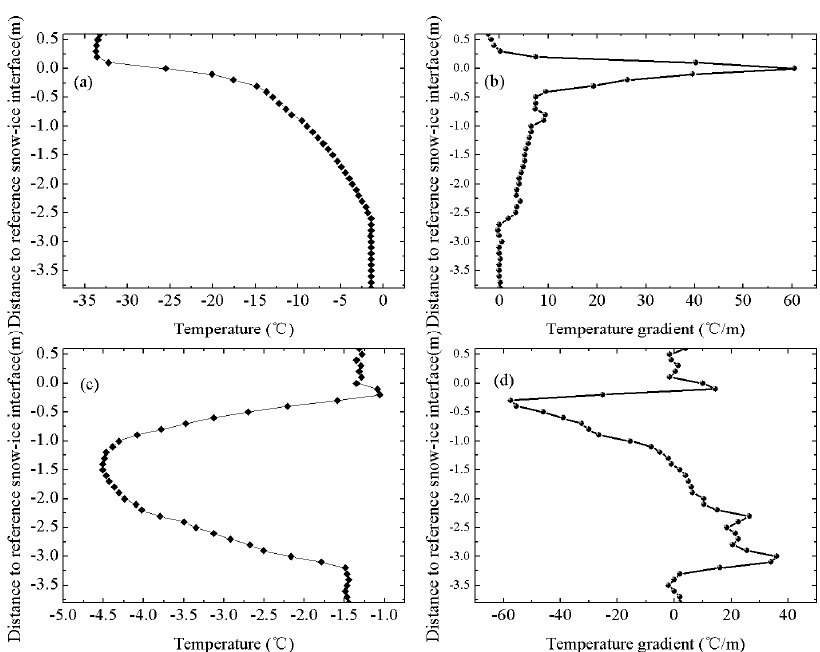
Figure 15. ( a ) Temperature profile of IMB-2007E in growth period. ( b ) The vertical gradients of temperature profile of IMB-2007E in growth period. ( c ) Temperature profile of IMB-2007E in warming period. ( d ) The vertical gradients of temperature profile of IMB-2007E in warming period. Two periods of sea ice can be identified based on the difference in shape between the temperature profiles and the vertical temperature gradients of two periods.